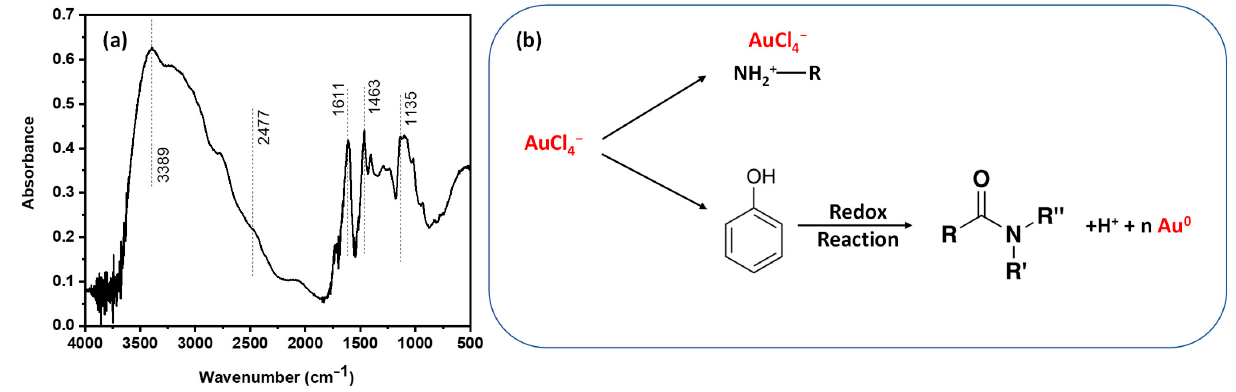
Figure 1. ( a ) FTIR spectrum of the Tanfloc powder and ( b ) possible scheme for adsorption and reduction mechanism of (Au (III)) by Tanfloc. reduction mechanism of (Au (III)) by